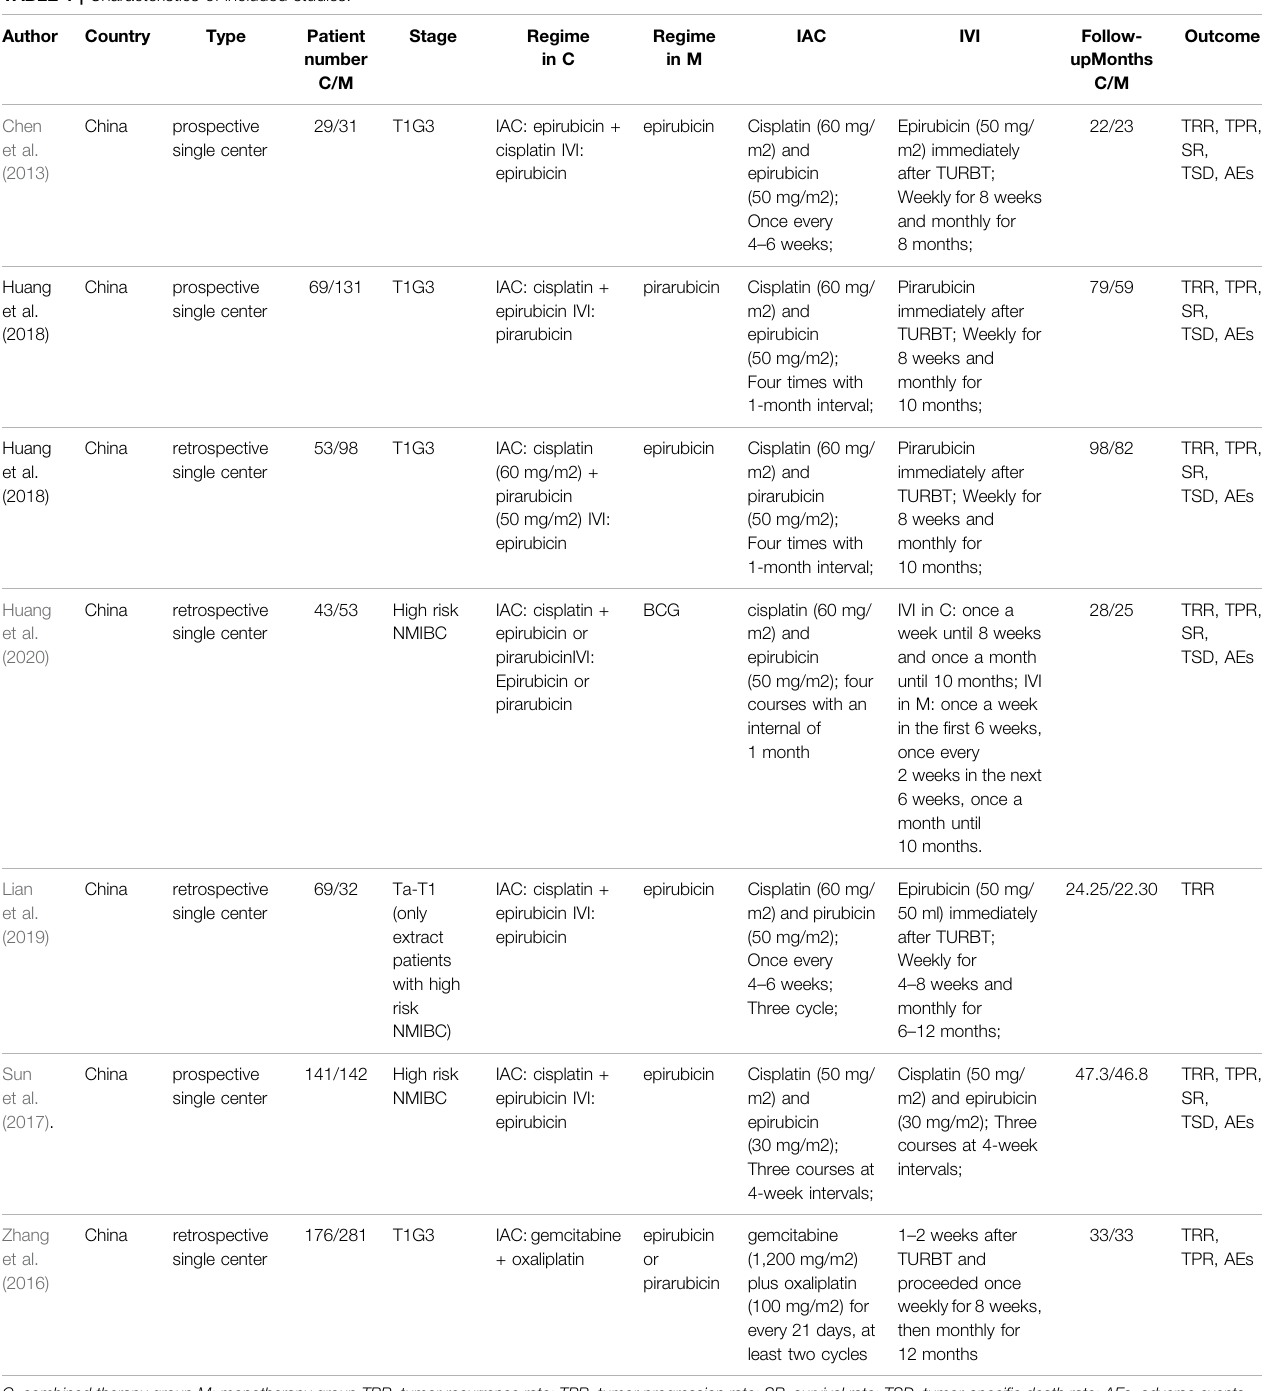
TABLE 1 | Characteristics of included